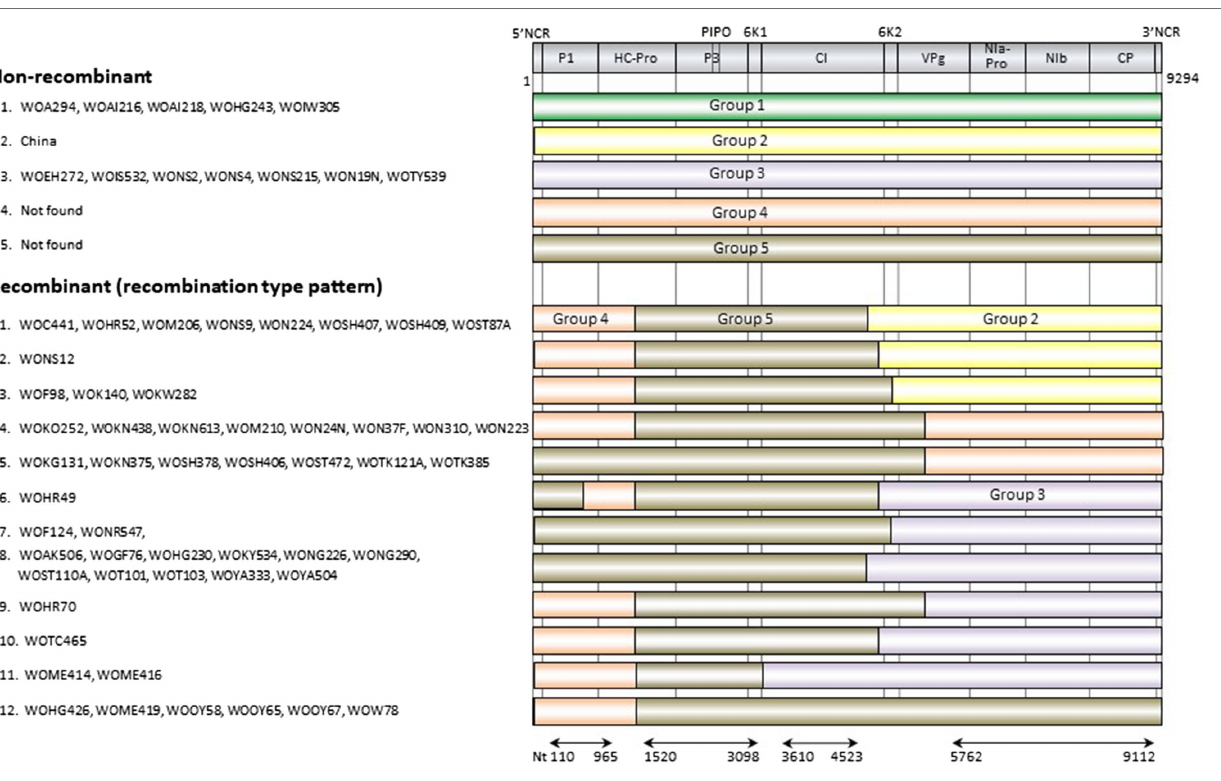
FIGURE 4 | Recombination genome map of scallion mosaic virus genomes of the isolates. Vertical solid lines show estimated approximate recombination sites. The nucleotide positions are shown relative to the 5 ' end of the genome using the numbering of the aligned and degapped sequences used in the present study, nearly complete genomic sequences of 9,294 nt long excluding the 5 ' end of 26 nucleotides that were used to design the primer for RT-PCR amplification (see Materials and Methods). The horizontal arrows show the regions used to infer phylogenetic trees from non-recombinant sequences ( Figure 5